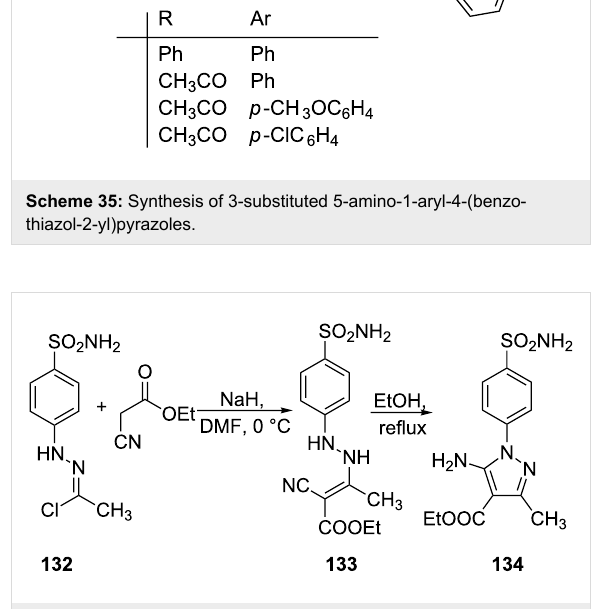
The potassium salt of ethyl cyanopyruvate 138 on reaction with methyl carbazate 139 in a mixture of chloroform and ethyl acetate, saturated with hydrogen chloride resulted in situ proto- nation of the potassium salt followed by formation of